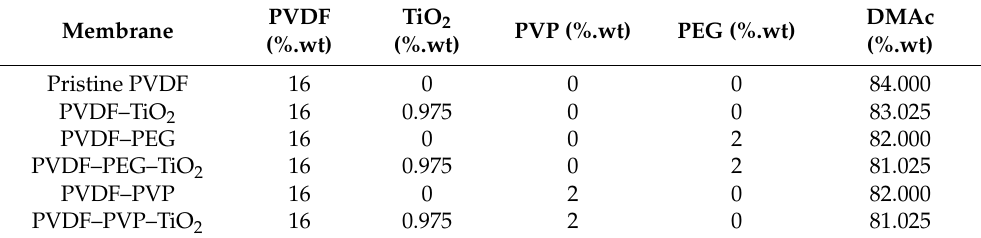
Table 1. Dope solutions for flat sheet